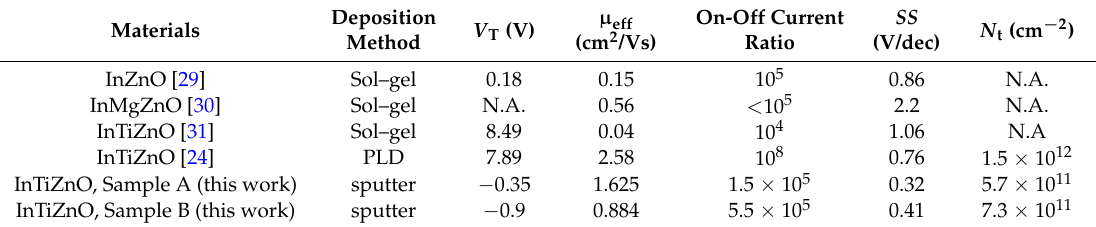
Table 2. Electrical performance of ZnO-based TFTs reported in the